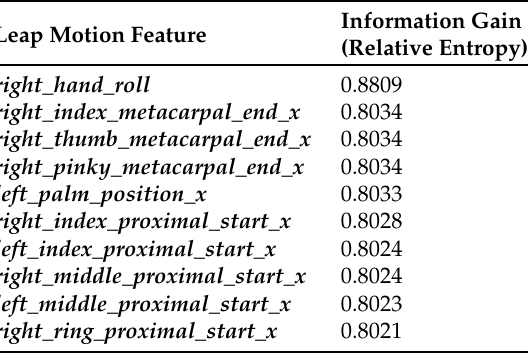
Figure 13. Confusion matrix for the best model (multimodality, 76.5%) on the set of unseen data (not present during training). Table 5. The top ten features by relative entropy gathered from the Leap Motion